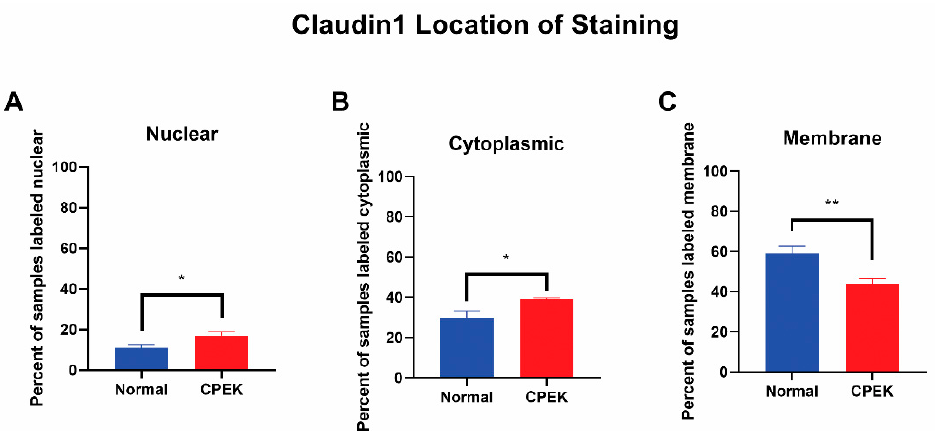
Figure 7. Claudin-1 location of staining. Percent shown is the number of observers who labeled staining in each location. Statistical analysis by welch unequal variance t -test showed normal vs. CPEK staining was significantly different in nuclear, cytoplasmic, and membrane staining with p -values of 0.0318, 0.0172, and 0.0026, respectively. * indicates a significance of p higher than 0.01 while ** is a significance of p less than